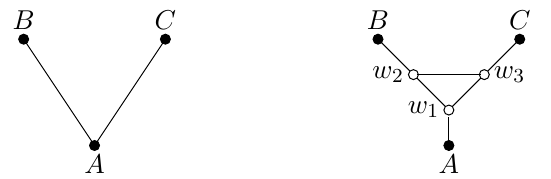
Figure 8 . Triangle gadget. The interaction pattern on the left is simulated by the interaction pattern on the right by (cid:12)rst applying the subdivision gadget to edges AB and AC , and then applying the fork gadget to qudit A